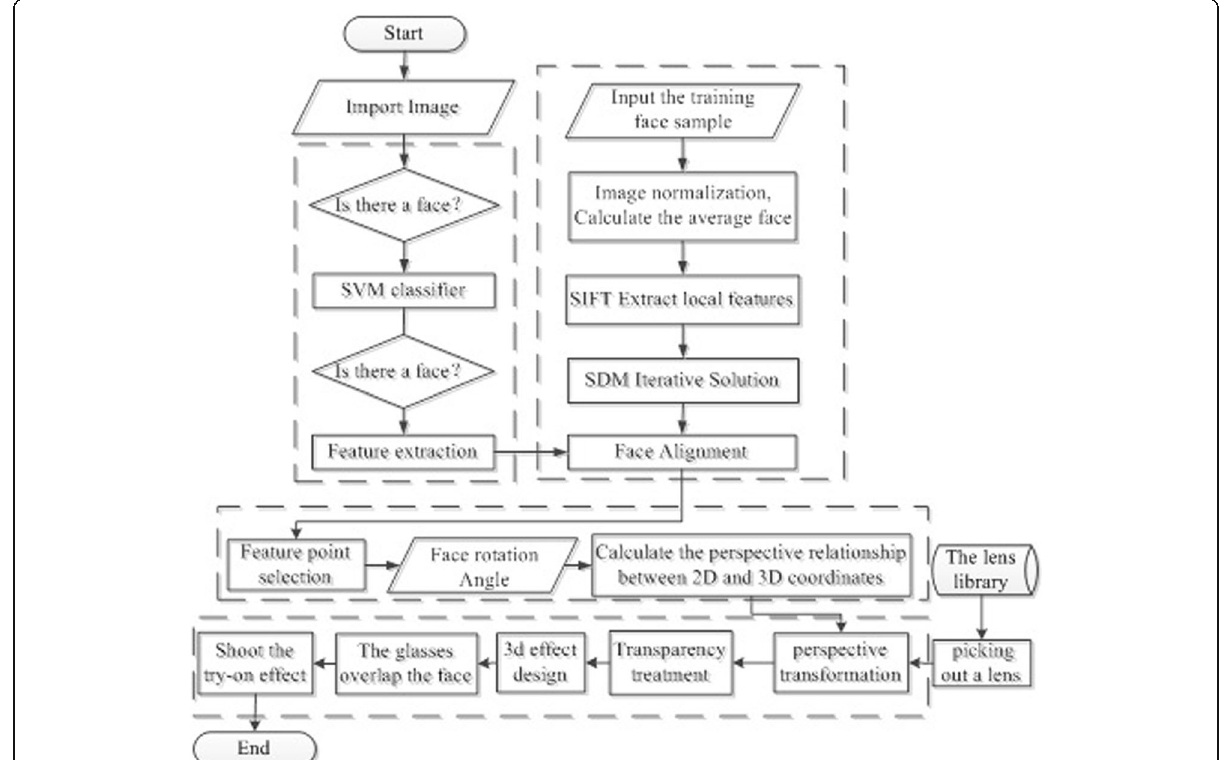
Fig. 23 The detailed flow chart of eyeglass